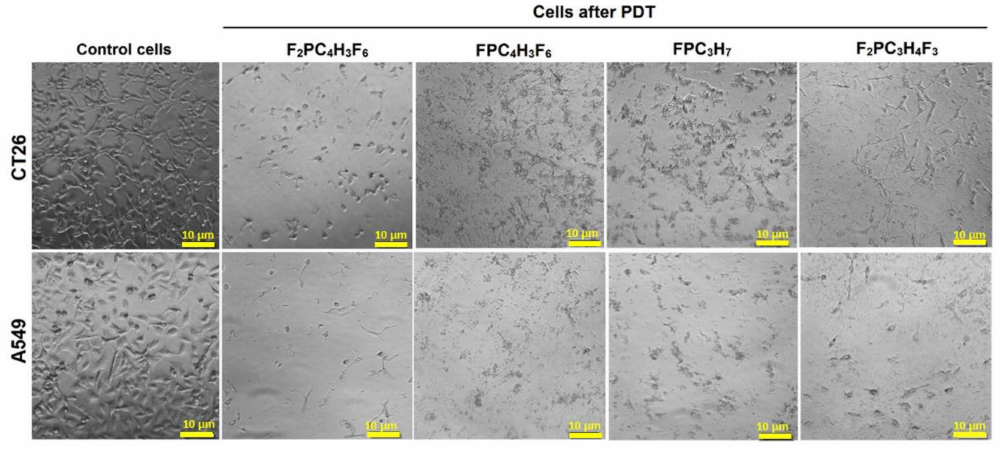
Figure 9. The morphology of A549 and CT26 cells before and 24 h after photodynamic e ff ect with sulfonate ester porphyrins at the drug dose of 20 µ M and light dose of 5 J / cm 2